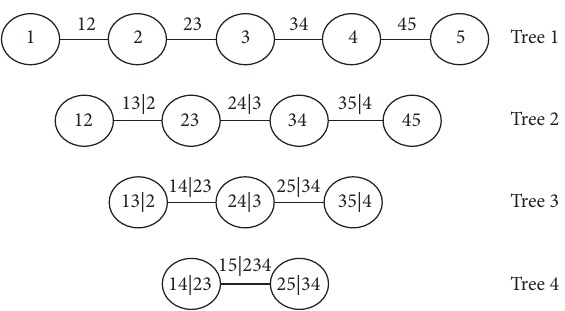
Figure 2: Five-dimensional D-vine